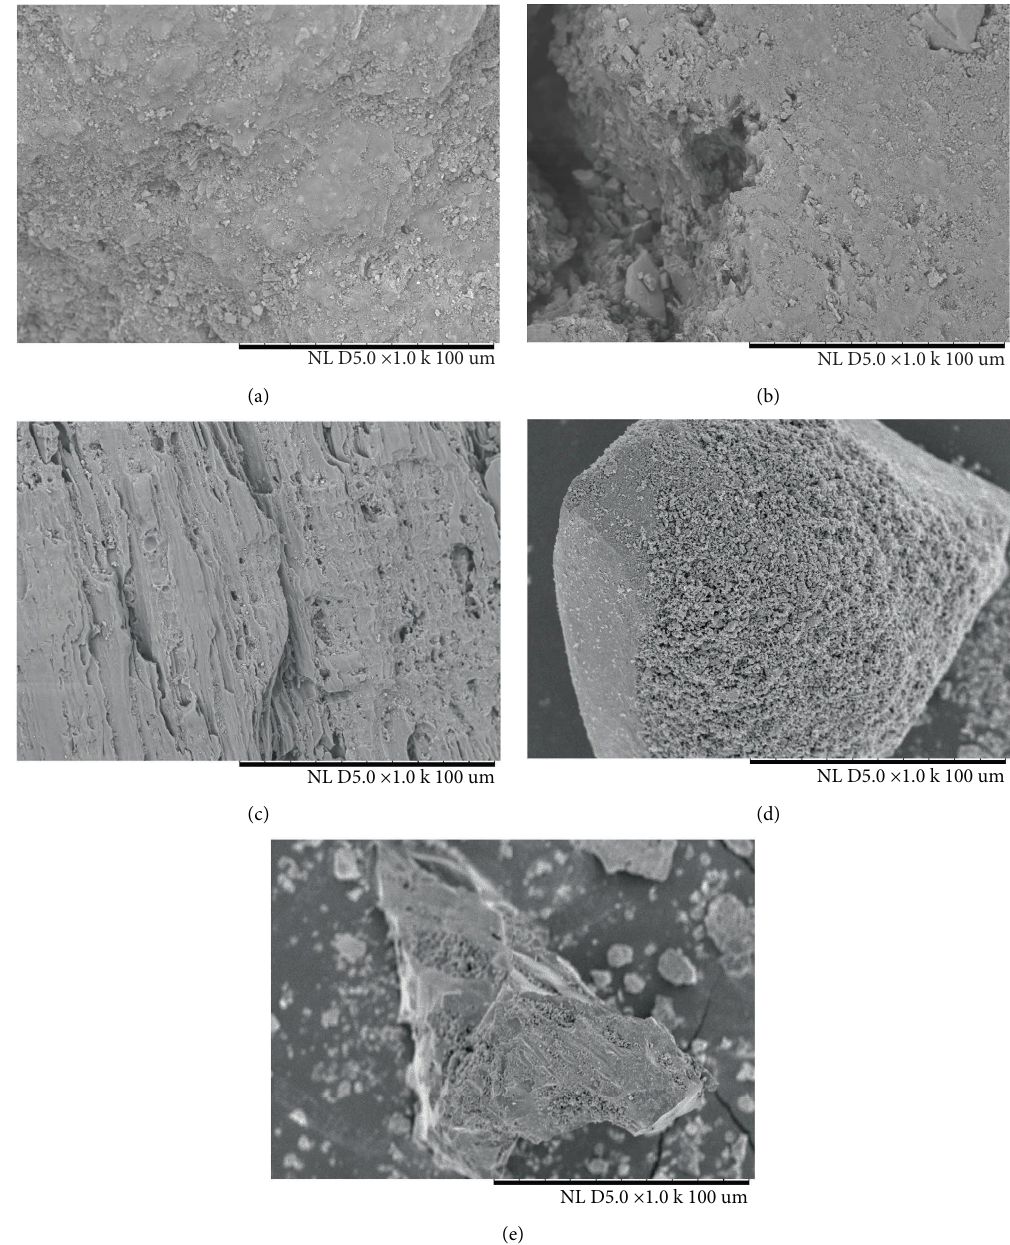
Figure 1: Representative FE-SEM images at 1000x magnifcation of the (a) untreated (AC), (b) SH samples. Images shown are representative of those seen from at least three such felds of view and three independent samples.